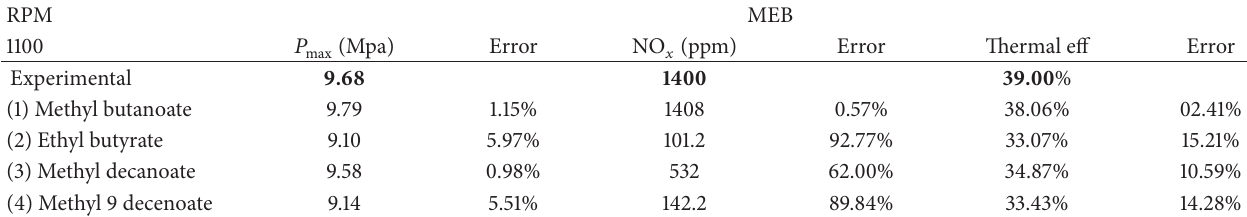
RPM Experimental